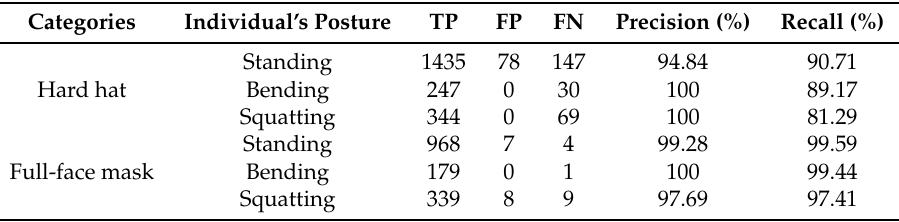
Table 5. Identification results under different individual